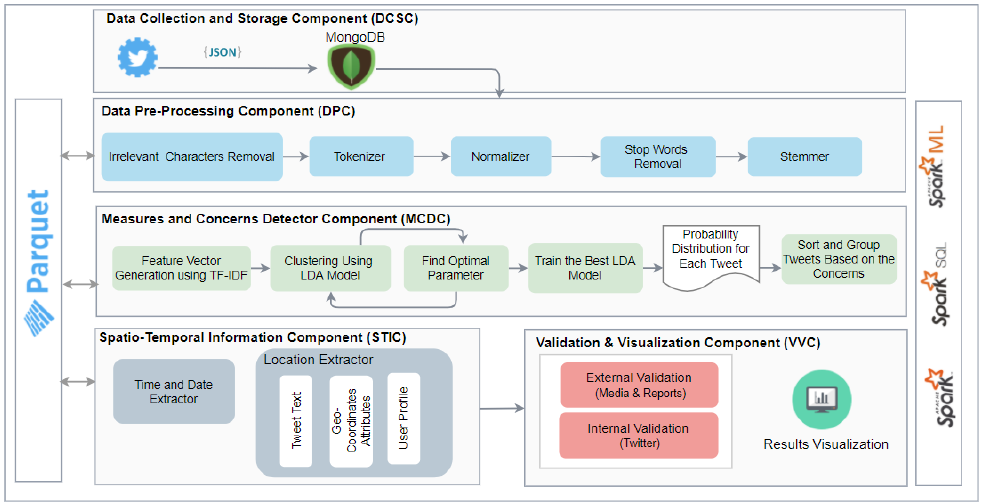
Figure 2. The tool